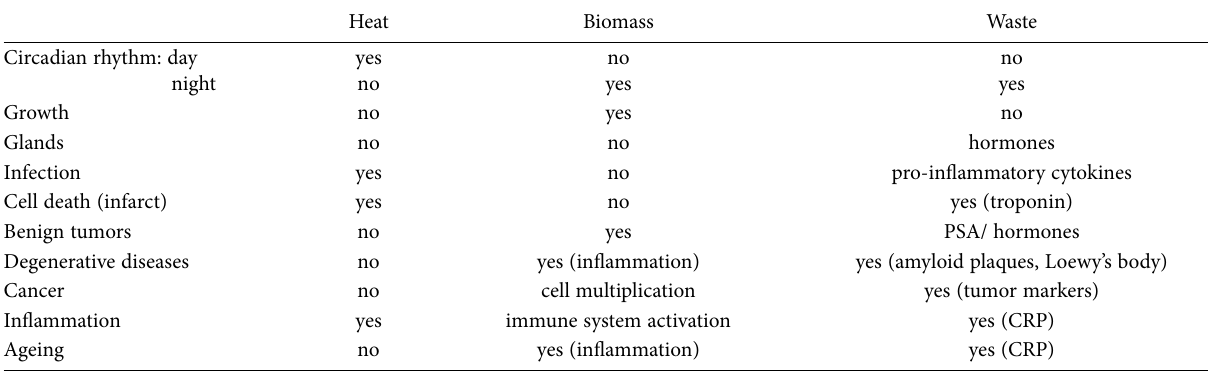
Table 1. Entropy release by the affected cell.